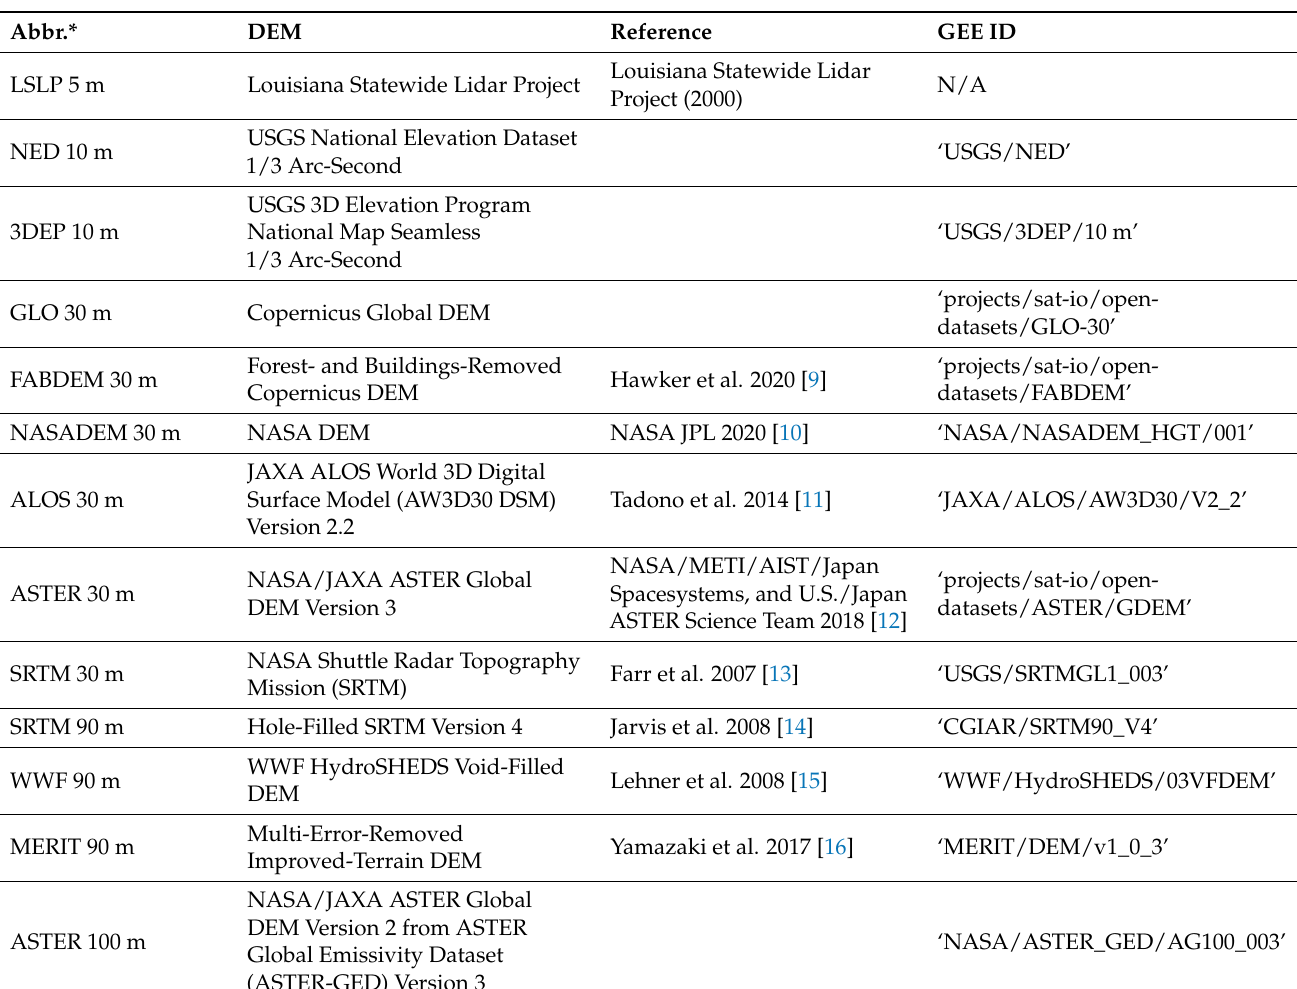
Table 2. DEM datasets used in FwDET intercomparison